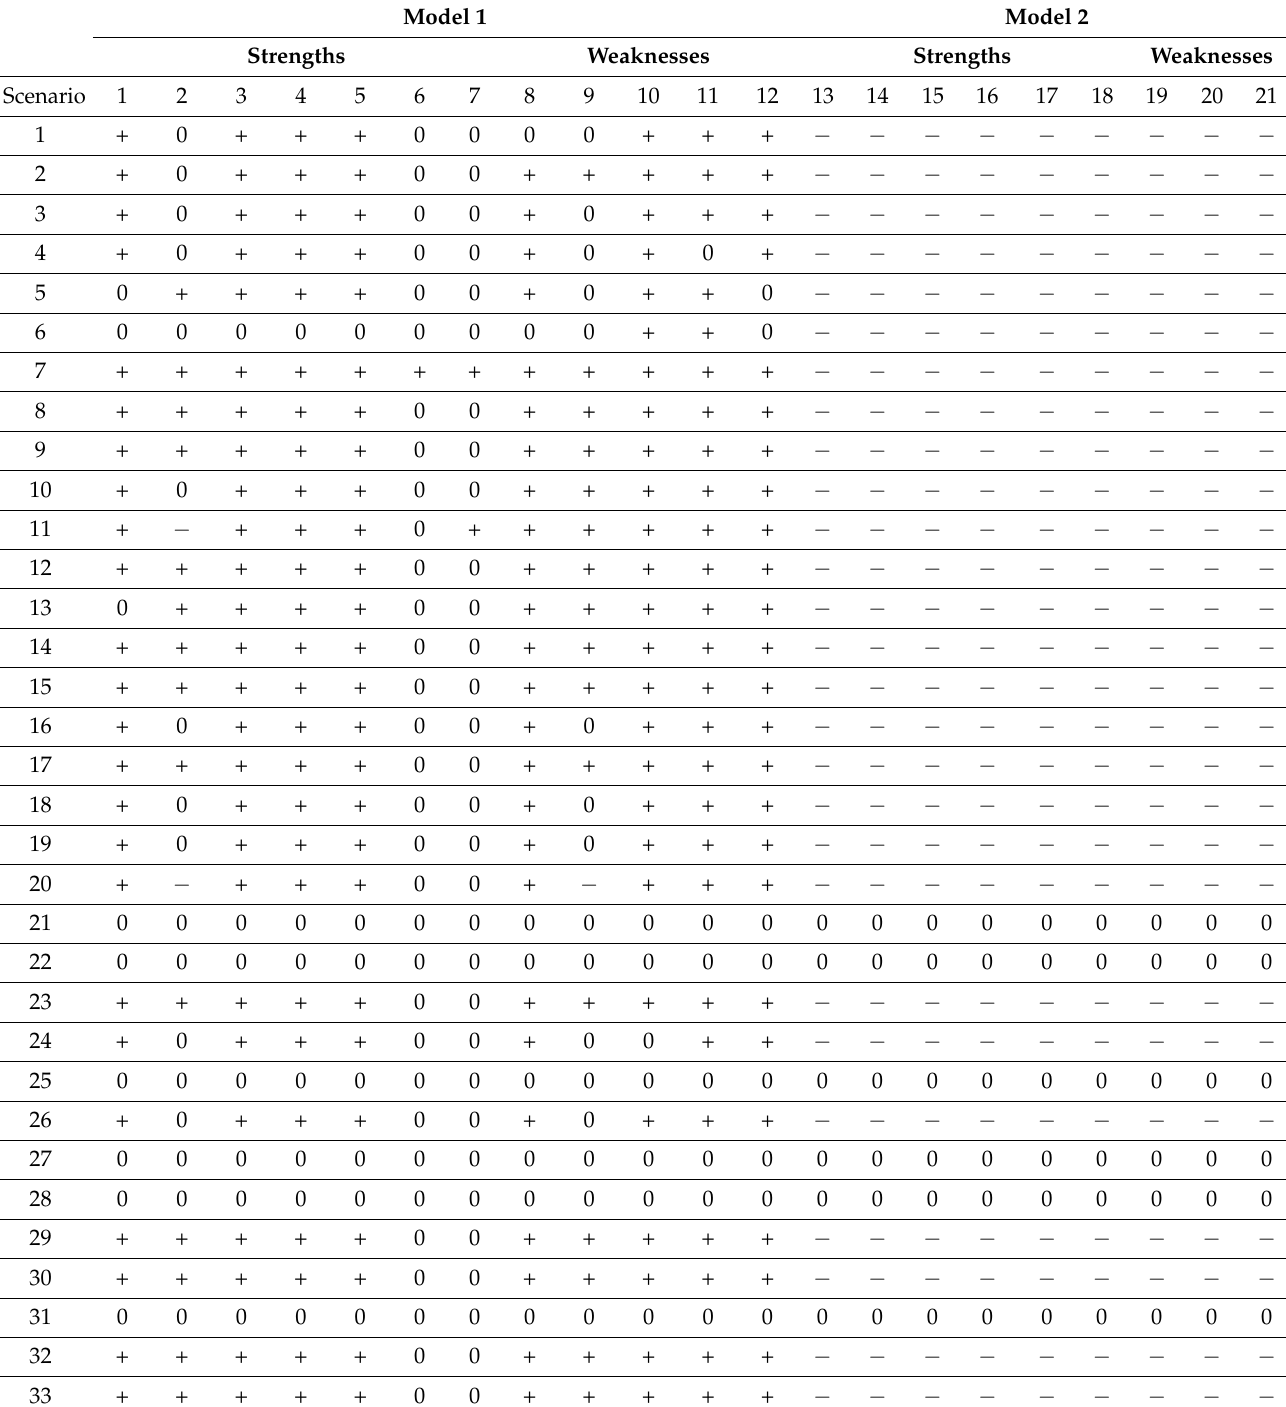
Table 2. Results of model 1 and model 2 for the base cases. Model 1 Model